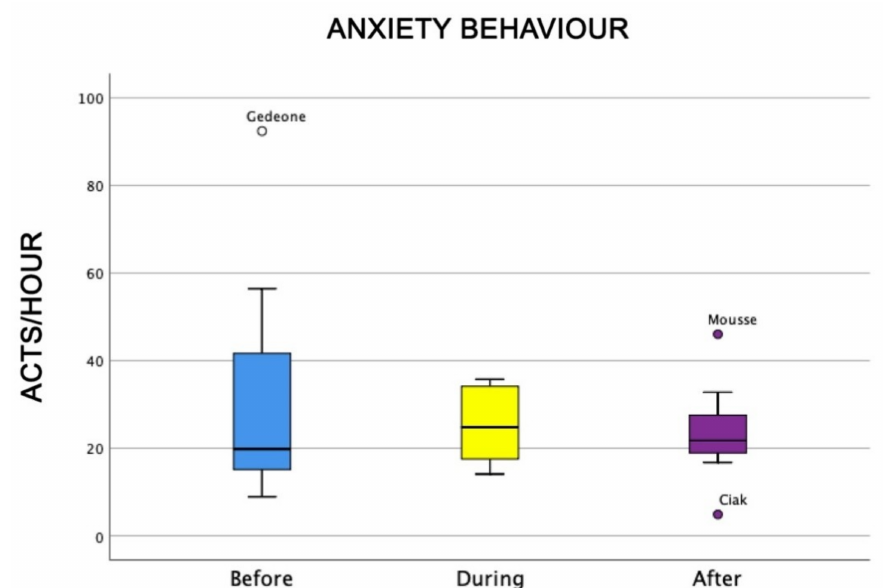
Figure 1. Behavioural patterns related to dogs’ level of anxiety towards humans before, during, and after animal-assisted intervention (AAI) sessions. Non-parametric data are represented as medians (horizontal bar in the box) and the box indicates the interquartile range of 50% of the data. Whiskers extend to the smallest and largest values and exclude outliers (dot on top).